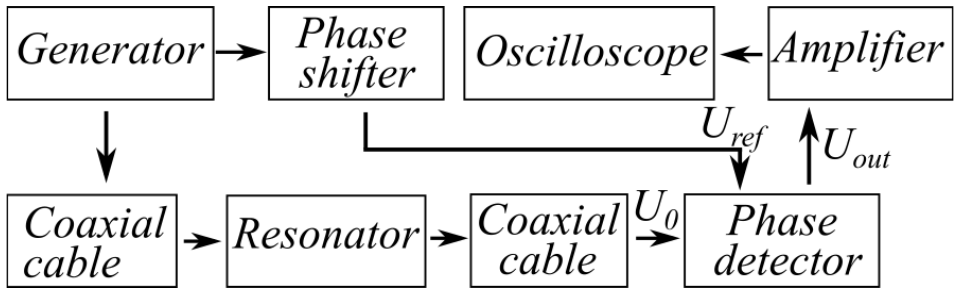
Figure 2. Block diagram of amplitude-phase humidity